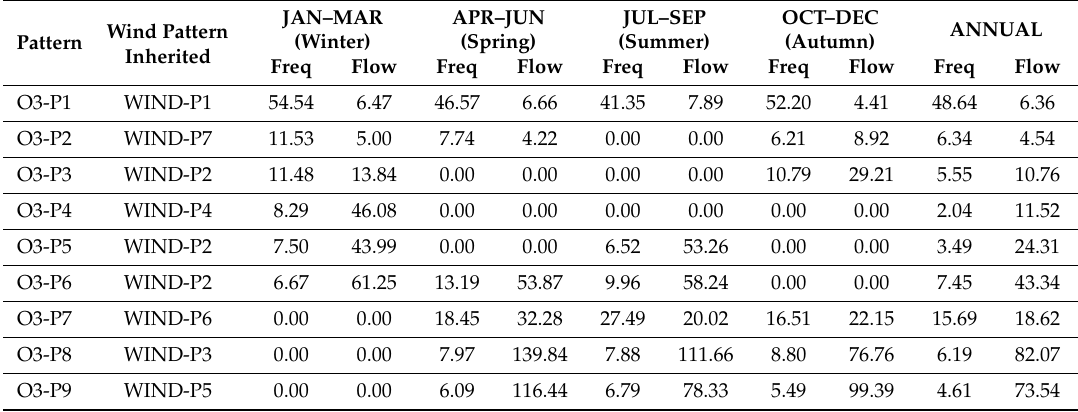
Table 5. Frequencies (%) and flow intensities (µg/m 2 s) of the Mexico City O 3 flow patterns (2001– 2010)